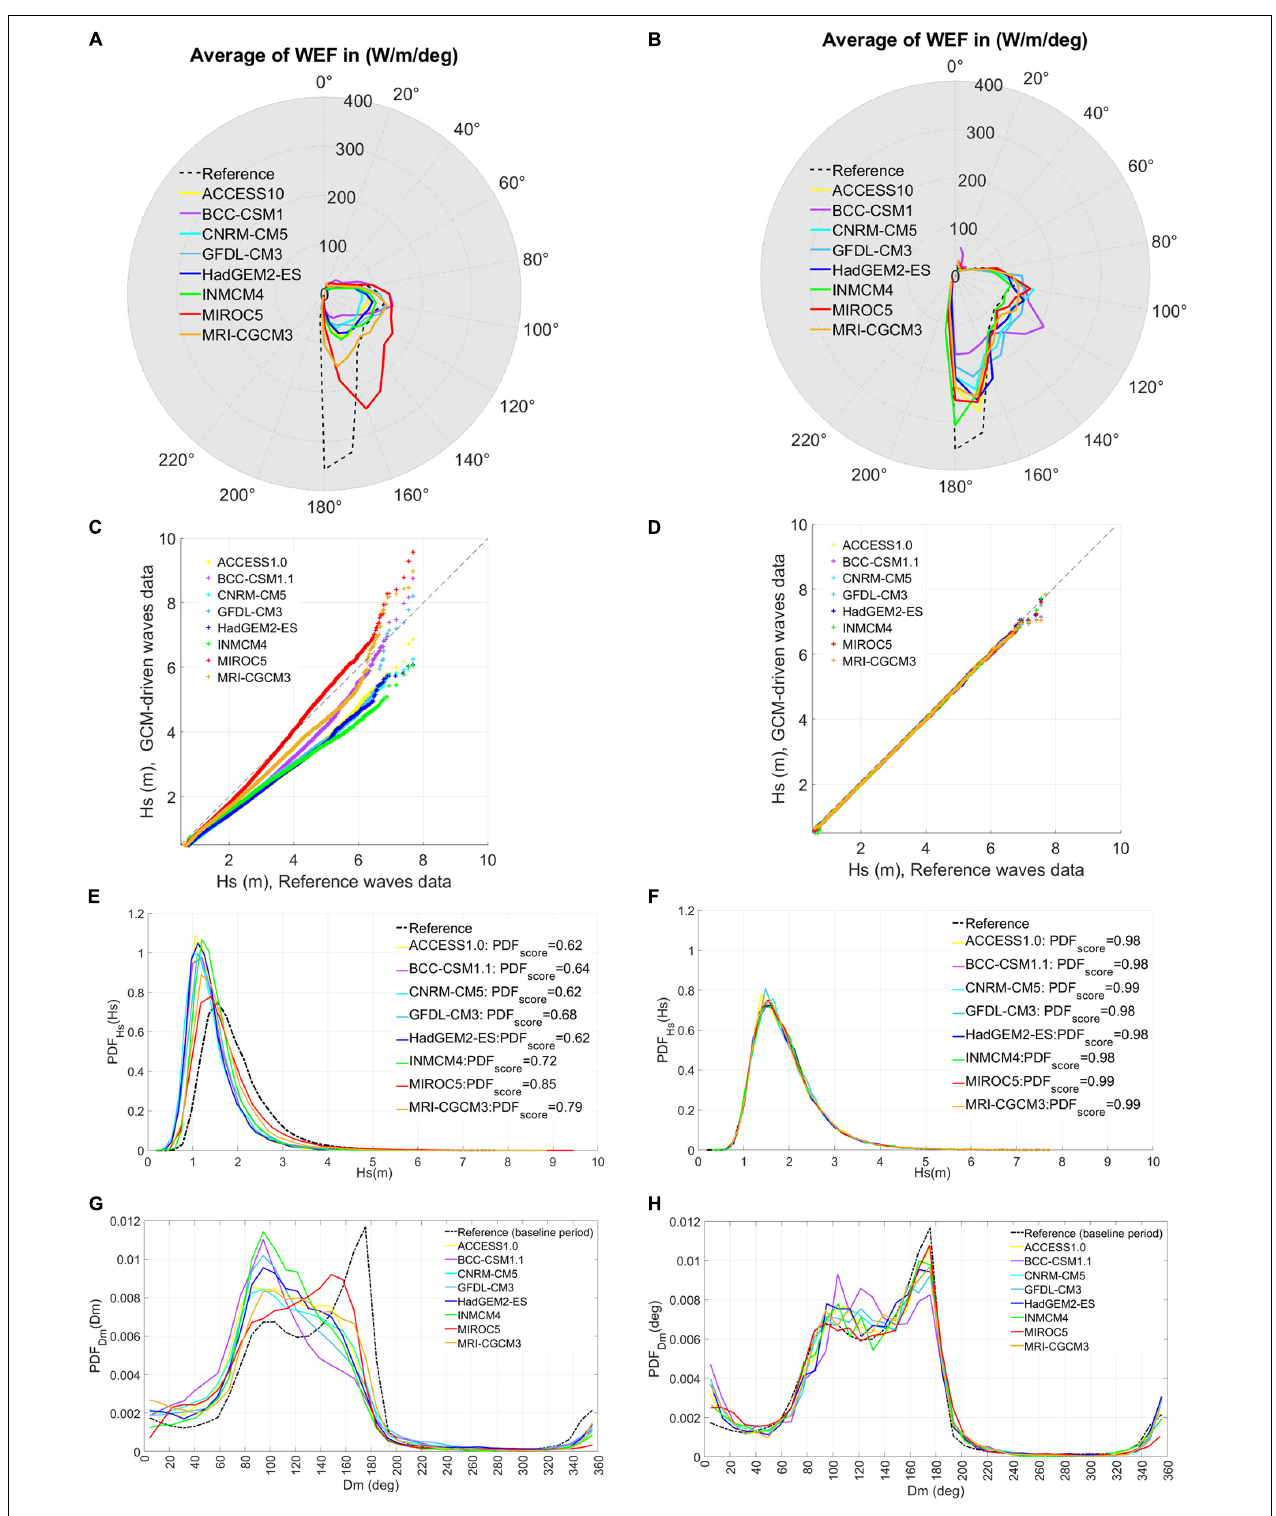
FIGURE 5 | Comparison of bias-corrected and original datasets of GCM-Ws for the baseline period 1979–2005. (A) Average of wave energy flux presented by the original datasets. (B) Average of wave energy flux presented by the bias-corrected datasets. (C) QQ plots for H s of the original datasets. (D) QQ plots for H s of the bias-corrected datasets. (E) PDF for H s of the original datasets. (F) PDF for H s of the bias-corrected datasets. (G) PDF for D m of the original datasets. (H) PDF for D m of the bias-corrected